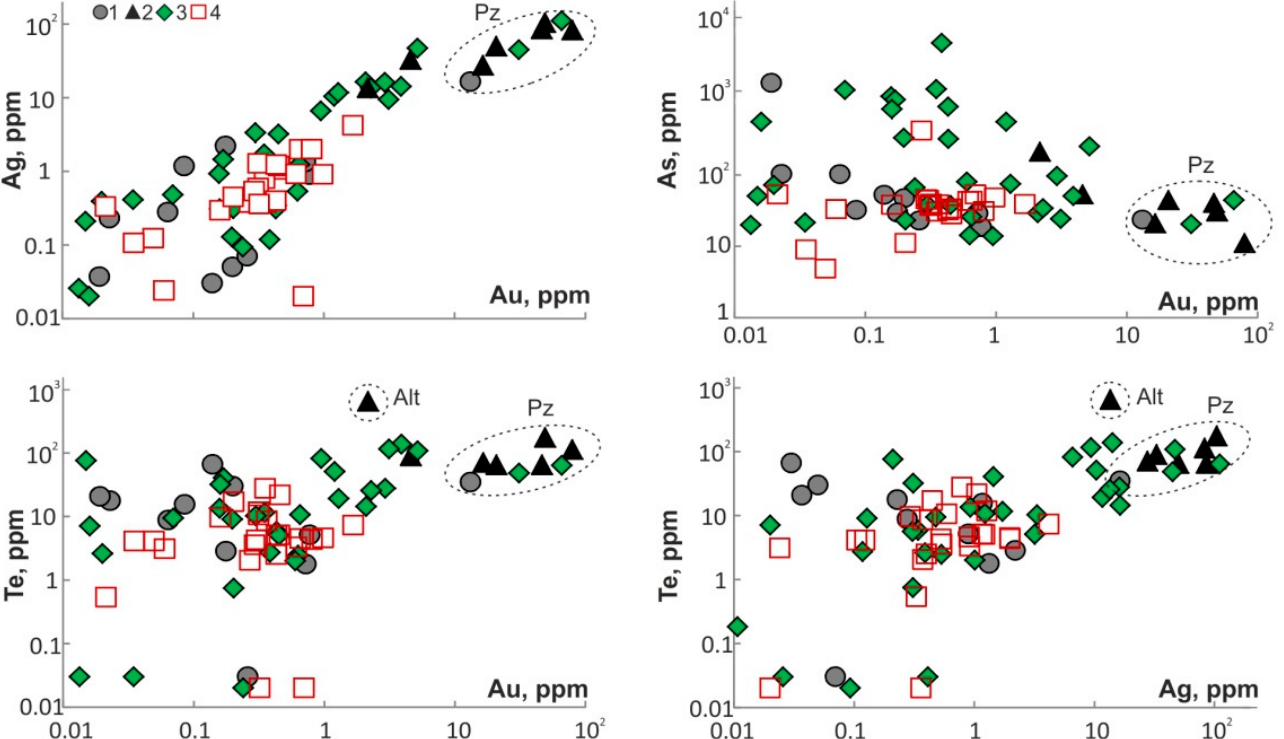
Figure 16. Binary diagrams of the contents of Au, Ag, Te and As in pyrite of the Petropavlovsk gold-porphyry deposit according to LA-ICPMS analyses. Mineral assemblages in ores: 1—skarn-magnetite; 2—gold-sulphide; 3—gold-telluride; 4—quartz-carbonate. The dashed line counters the probable submicroscopic inclusions of altaite (C Pb = 104–838 ppm) and petzite.